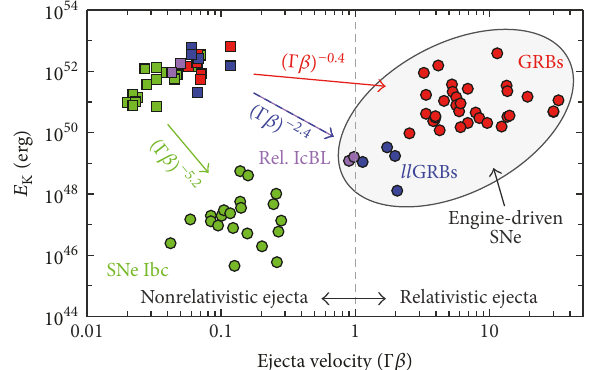
Figure 7: The positions of GRBs, SNe Ibc, and GRB-SNe in the 𝐸 - Γ𝛽 plane [32, 78–81]. Ordinary SNe Ibc are shown in green, K 𝑙𝑙 GRBs in blue, relativistic SNe IcBL in purple, and jetted-GRBs in red. Squares are used for the slow-moving SN ejecta, while circles represent the kinetic energy and velocity of the nonthermal radio- emitting ejecta associated with these events (e.g., the GRB jet). The velocities were computed for 𝑡 − 𝑡 0 = 1 day (rest-frame), where the value Γ𝛽 = 1 denotes the division between relativistic and nonrelativistic ejecta. The solid lines correspond to (green) ejecta ∝ kinetic energy profiles of a purely hydrodynamical explosion 𝐸 K (Γ𝛽) −5.2 [57, 82, 83]; (blue/purple dashed) explosions powered by a short-lived central engine (SBO-GRBs and relativistic IcBL SNe ∝ (Γ𝛽) −2.4 ); (red) those arising from a 2009bb and 2012ap: 𝐸 K ∝ (Γ𝛽) −0.4 [84]). long-lived central engine (i.e., jetted-GRBs; 𝐸 K Modified, with permission, from Margutti et al. [78,